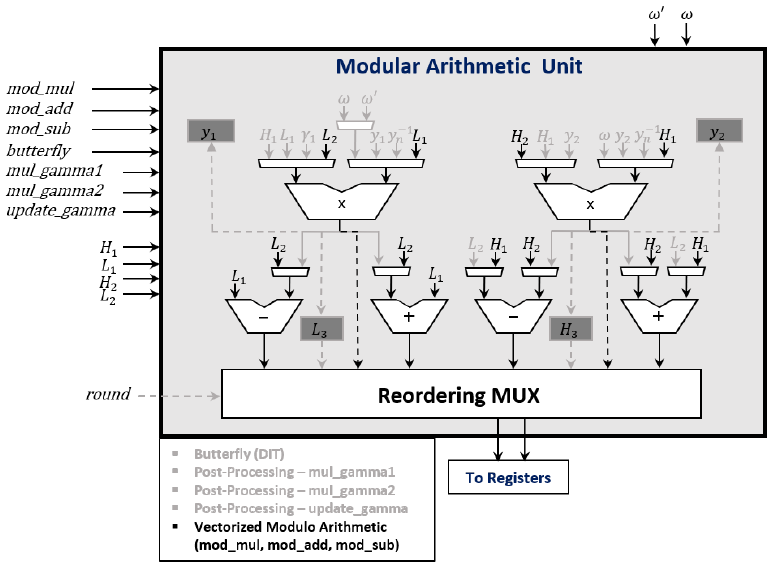
Figure 11: Modular Arithmetic Unit – Vectorized Modular